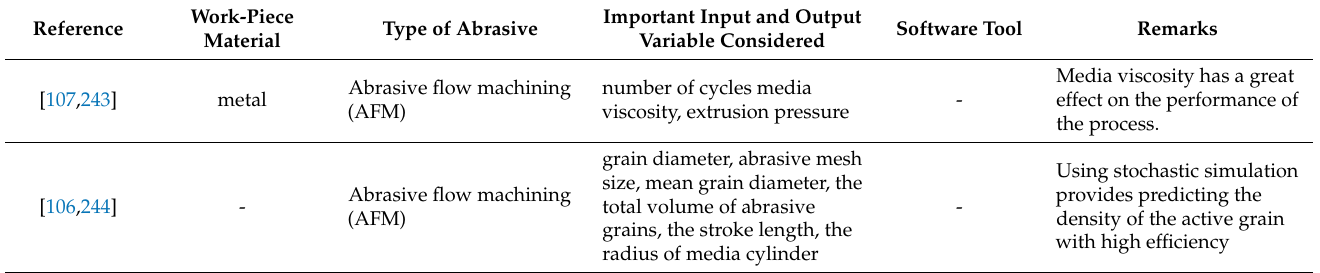
Table 13. Summary table of DDS-based modeling and simulation of the loose abrasive-based method.